Question: Sum up the contents of this chart in one sentence.
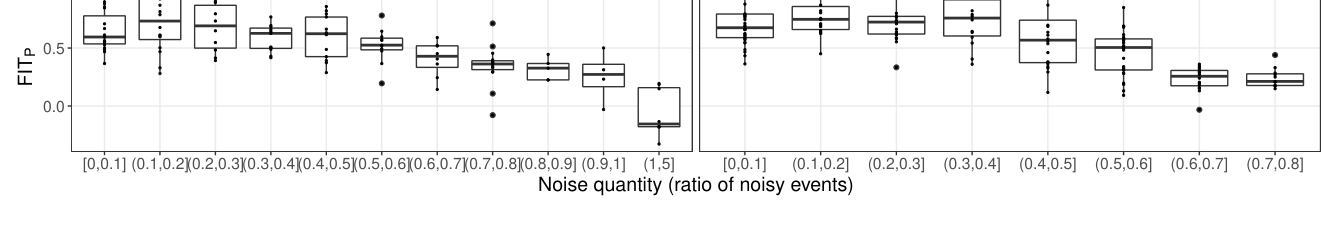
Answer: FITP values of SWoTTeD on synthetic data as a function of normalized noise (% of new or deleted events).